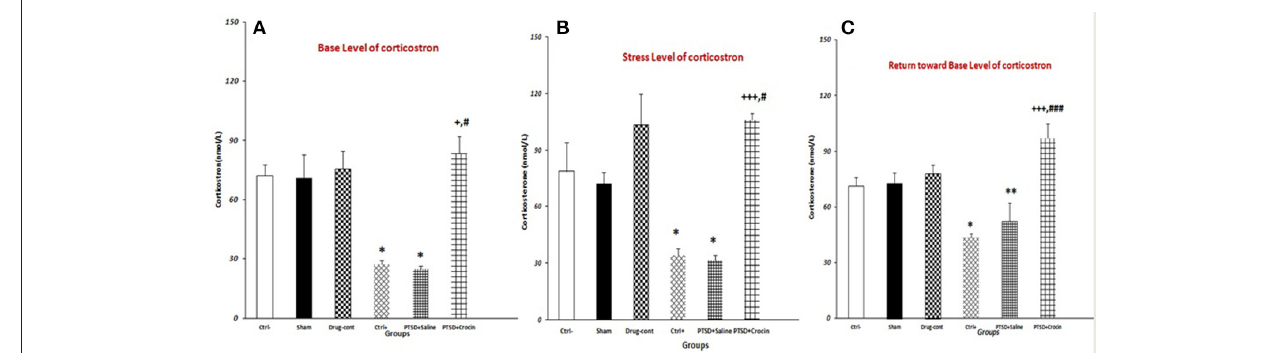
FIGURE 4 | Data are shown as mean ± SEM, n = 4 per groups. Evaluation of serum corticosterone under three conditions (basal, stress, return toward basal). (A) Evaluating basal serum corticosterone before re-exposure time; a significant increase was observed in the PTSD + Crocin group compared with the positive control and PTSD + saline groups ( + P < 0.05, # P < 0.05) and significant decreases in the positive control and PTSD + saline groups compared with the negative control group (* P < 0.05). (B) Stress-induced corticosterone increased post-shock; there was a significant increase in the PTSD + Crocin group compared with the positive control ( +++ P < 0.001) and PTSD + saline groups ( # P < 0.05) and significant decreases in the positive control and PTSD + saline groups compared with the negative control group (* P < 0.05). (C) At a later time point, there was a significant increase in PTSD + Crocin group compared with the positive control ( +++ P < 0.001) and PTSD + saline ( ### P < 0.001) groups and significant decreases in the positive control (* P < 0.05) and PTSD + saline (** P < 0.01) groups compared with the negative control group.